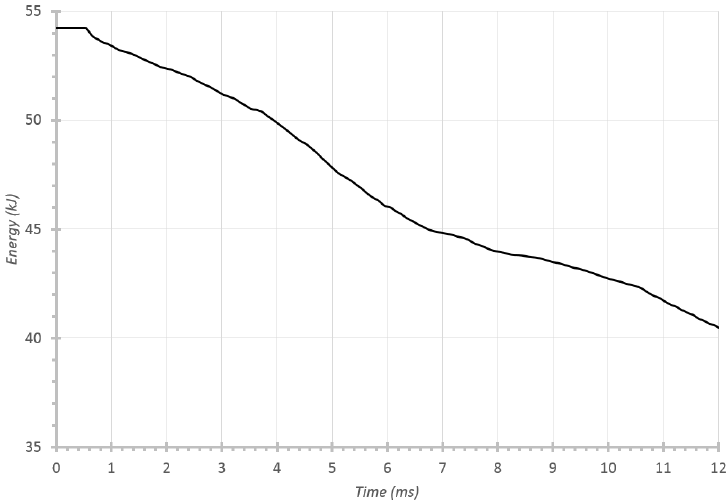
Figure 15. Temporal evolution of ballast kinetic energy with an initial impact velocity of 56 km/h.